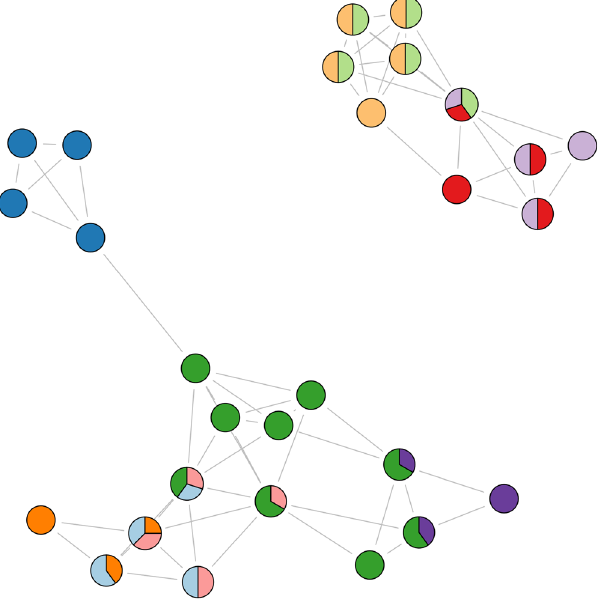
Fig. 1 Proximity-based social network of 28 rock hyraxes aggregated over the full study period (27 days). Circles depict individual hyraxes. Colours indicate community membership based on a community-detection algorithm. If a circle is fi lled with a pie chart, this individual was detected to be a member of multiple communities, and the pie charts represent the proportion of social interactions it allocates to its different